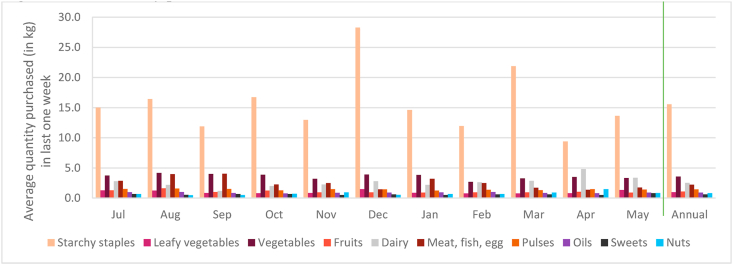
Quantity purchased.